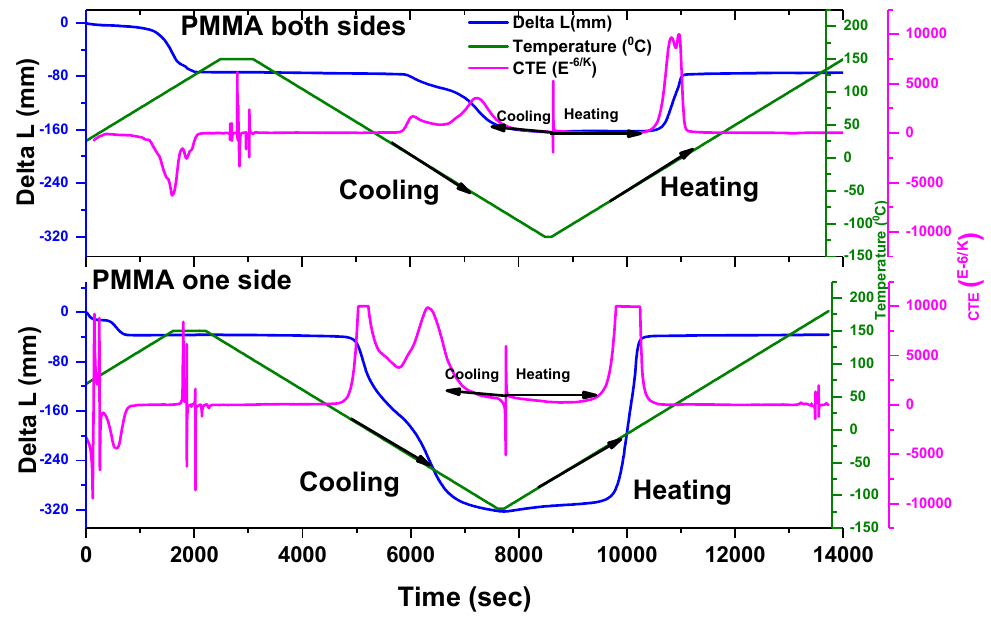
Figure 9. The coefficient of thermal expansion (CTE) response of the composite as a function of time.